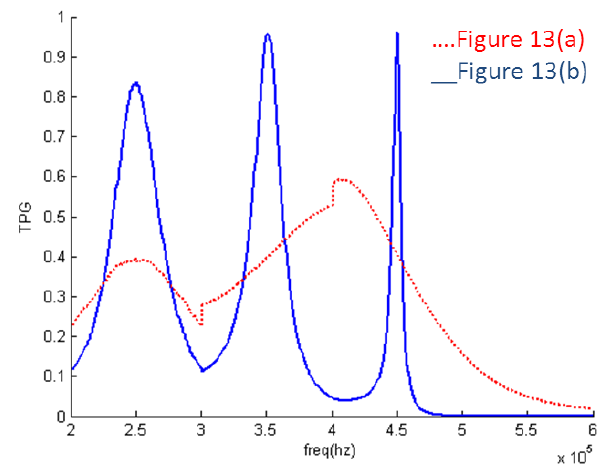
Figure 14. TPG of the EIMNs in Figure 13.